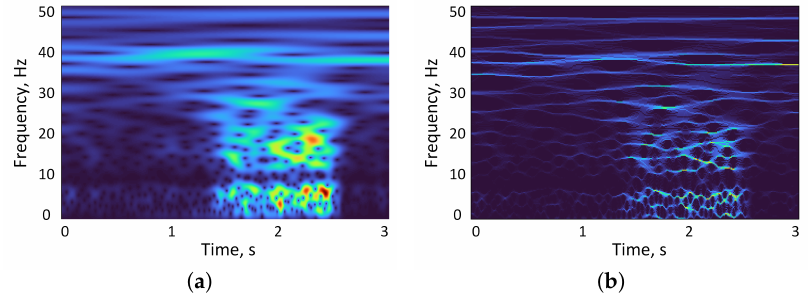
Figure 3. The comparison of CWT and SWT: ( a ) CWT example, ( b ) SWT